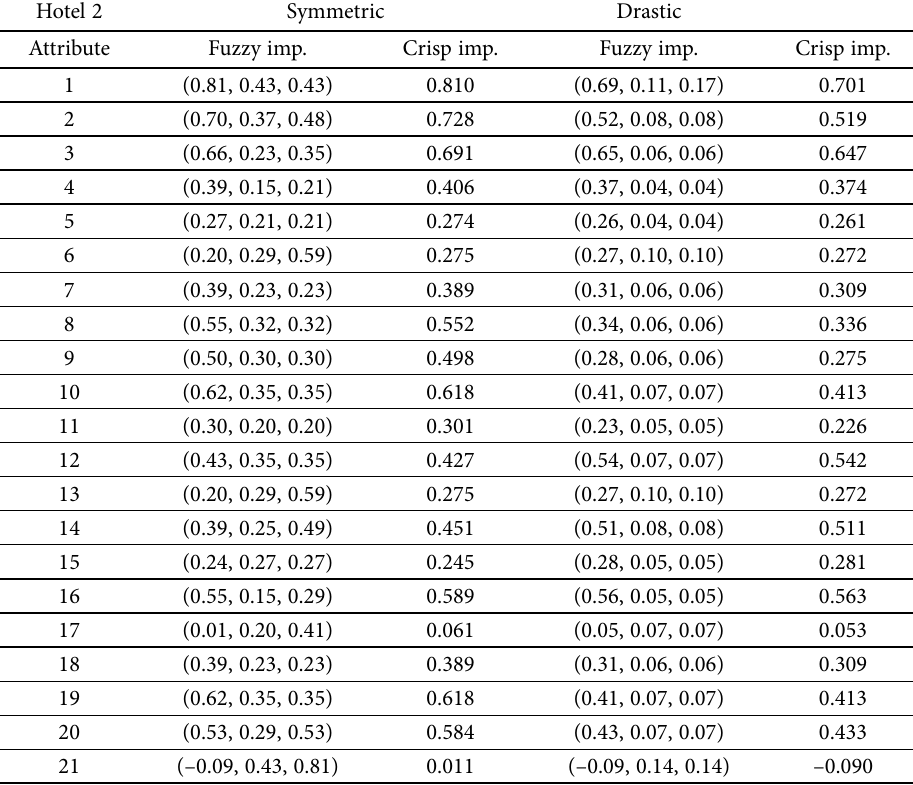
Table 7. Fuzzy importance and crisp importance of attributes – Hotel 2